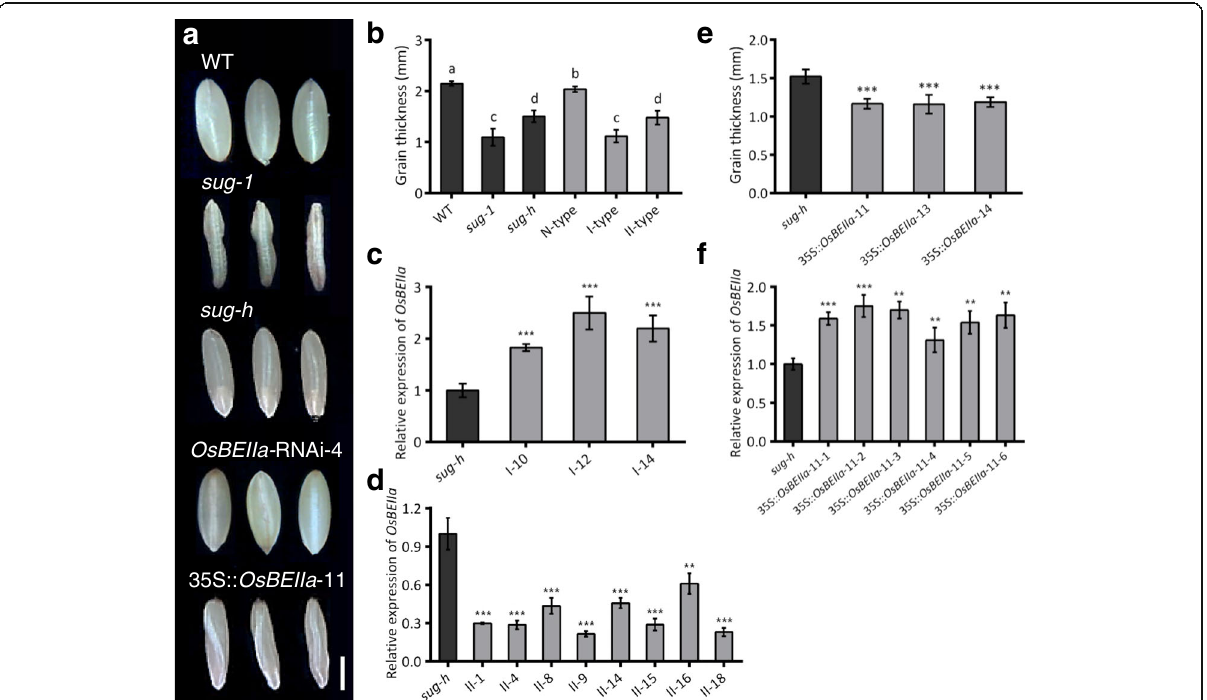
Fig. 5 Phenotype of transgenic seeds and complementation test of the sug-h mutation. a Grain morphologies of wild-type rice (Dongjin), sug-1 , sug-h , and transgenic seeds. Bar = 2 mm. b Comparison of grain thickness in F 2 seeds derived from OsBEIIa -RNAi-4/ sug-h . Different letters denote significant differences. Replicate samples were measured 20 times. c Relative expression level of OsBEIIa in each F 2 plant derived from I-type seeds using qRT-PCR. The sug-h mutant was used as a control. Error bars represent SD for three technical experiments. Asterisks indicate statistical significance compared with the control, as determined by Student ’ s t -test (*** P < 0.001). d Relative expression level of OsBEIIa in each F 2 plant derived from II-type seeds by qRT-PCR. Error bars represent SD for three technical experiments. Asterisks indicate statistical significance compared with the control, as determined by Student ’ s t -test (** P < 0.01, *** P < 0.001). e Comparison of grain thickness in three lines of 35S:: OsBEIIa and sug-h mutant seeds. Statistical significance was determined by Student ’ s t -test (*** P < 0.001). Replicate samples were measured 20 times. f qRT-PCR analysis showed increased OsBEIIa expression in 35S:: OsBEIIa -11 T 1 plants. Error bars represent SD for three technical experiments. Statistical significance was determined using Student ’ s t -test (*** P <